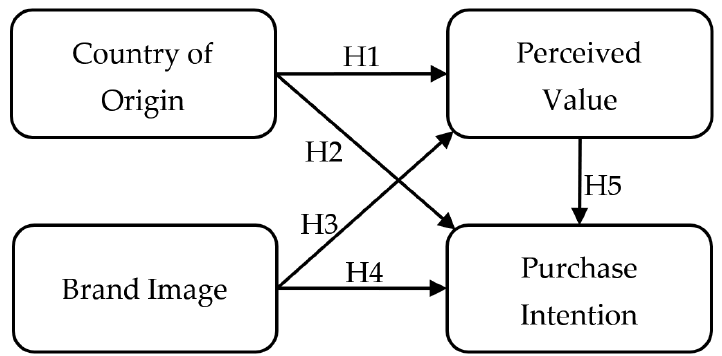
Figure 1. A Theoretical Model of Purchase Intention.